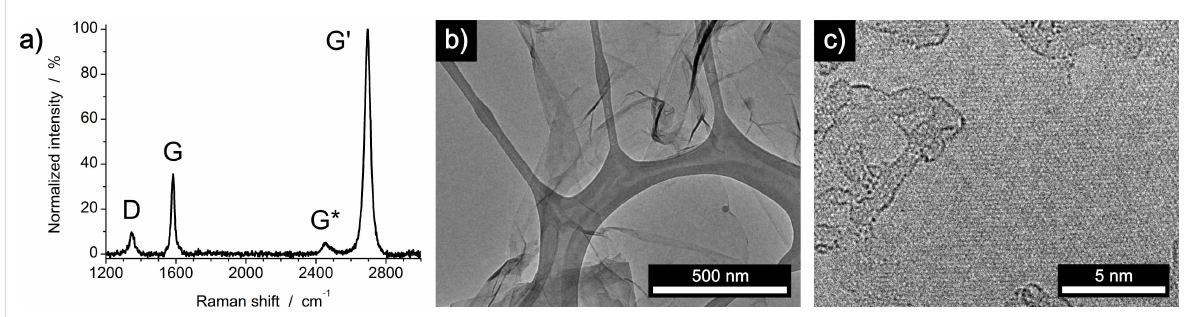
Figure 1: Characterization of graphene obtained by the modified etching process with an aqueous solution of ammonium persulfate. a) Representa- tive Raman spectrum of graphene normalized to the intensity of the G’ peak. The spectral location of the G and G’ peak, the intensity ratio of G’/G and the full width at half maximum of the G’ peak indicate the synthesis of single to few layer graphene. b) and c) High-resolution TEM images of as-syn- thesized